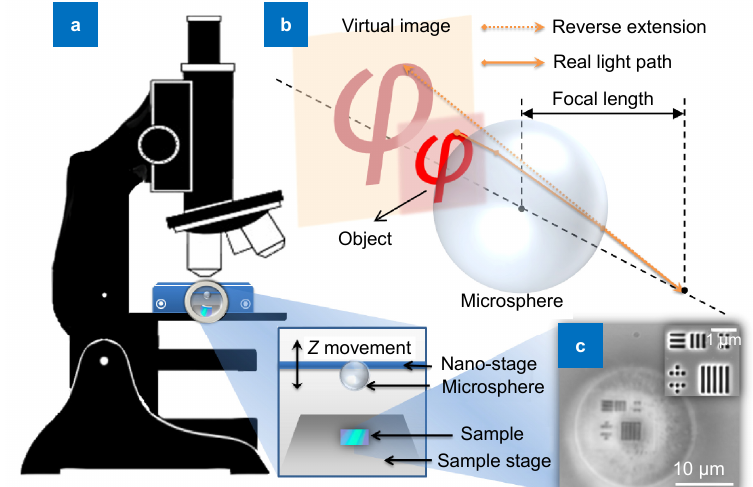
Fig. 1 | ( a ) Schematic diagram of the remote mode optical microsphere setup. ( b ) Mechanism to illustrate the enlarged virtual image by the microsphere. ( c ) Optical image captured by this system (Sample: semiconductor testing sample; scale bar: 10 µm; imaged by a 20 μ m silica microsphere compiled to an oil-immersion optical microscope with a 100× objective lens, NA=1.4). Inset: SEM image (scale bar: 1